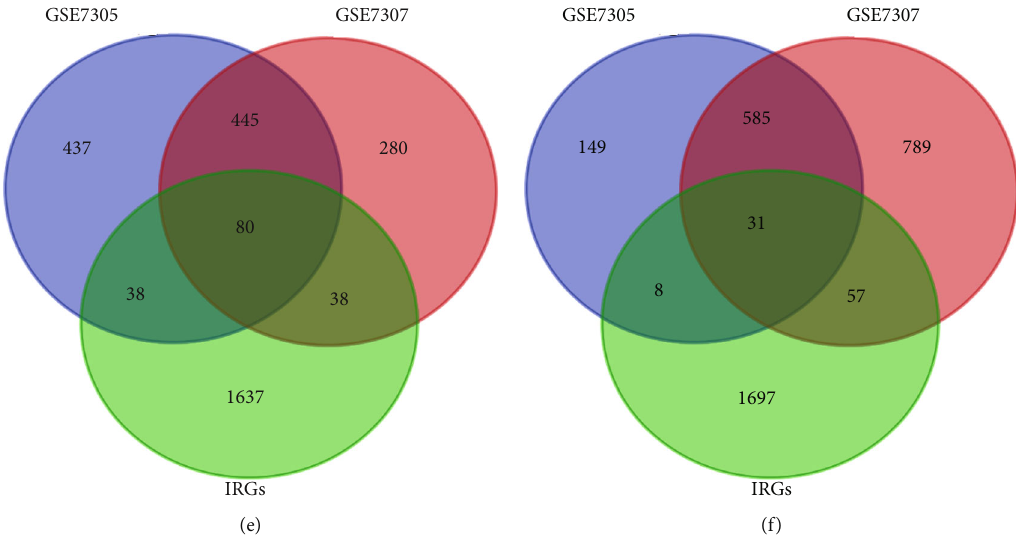
Figure 2: Identi fi cation of 94 DETFs and 111 DEIRGs in endometriosis. (a, b) Volcano plot of DEGs in GSE7305 and GSE7307. Red and blue data points represent upregulation and downregulation, respectively. (c, d) Identi fi cation of 35 upregulated and 59 downregulated DETFs from GSE7305, GSE7307 and TFs. (e, f) Identi fi cation of 80 upregulated and 31 downregulated DEIRGs from GSE7305, GSE7307, and